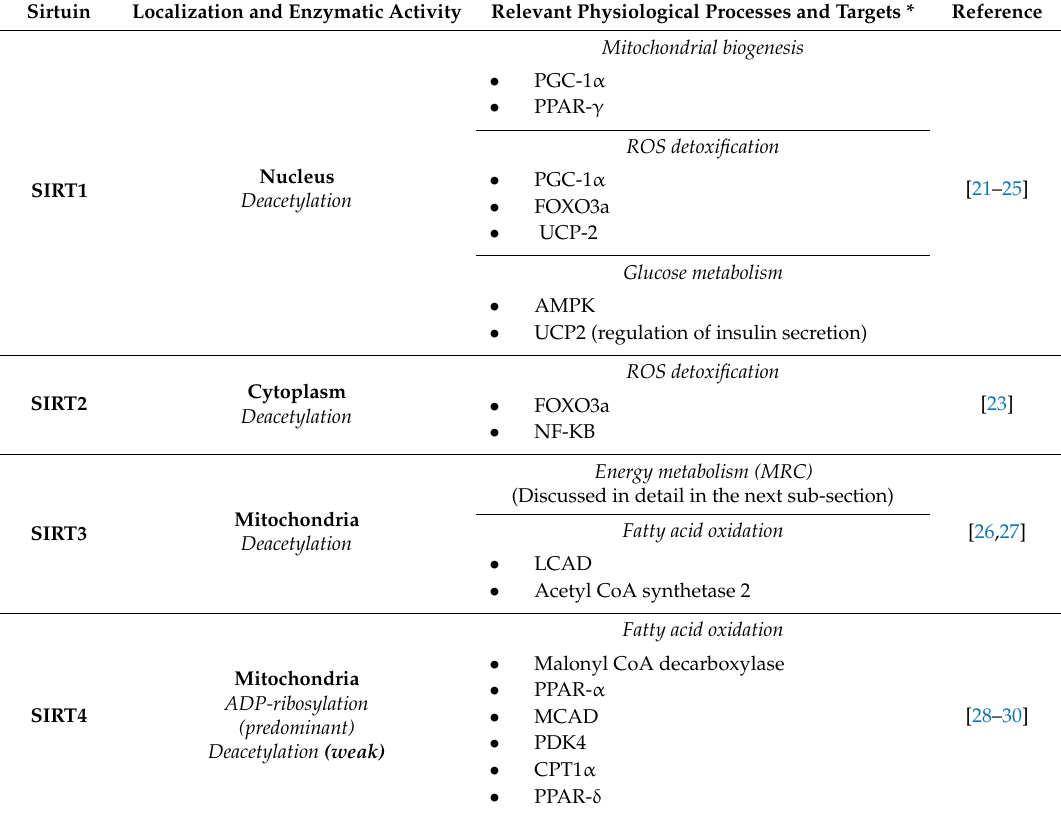
Table 1. Sirtuins (SIRT 1–4): localization, enzymatic activity, * targets (relevant to potential mechanisms of action of ketogenic